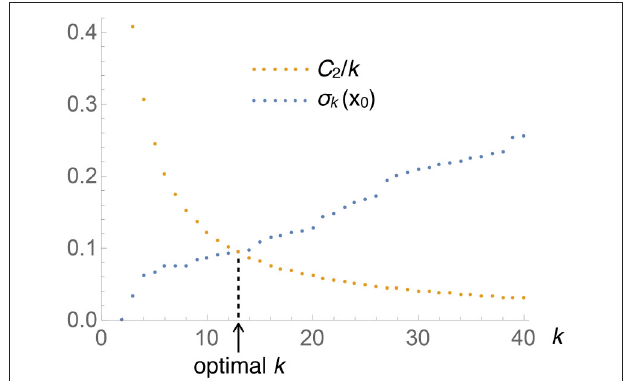
FIGURE 1 | Graphical illustration of the determination of the optimal number of nearest neighbors, k , to be used at each test point x (this particular plot corresponds to the univariate Old Faithfual data set, at x 0 = 3.59). The intersection of both curves provides the solution to Equation (8).